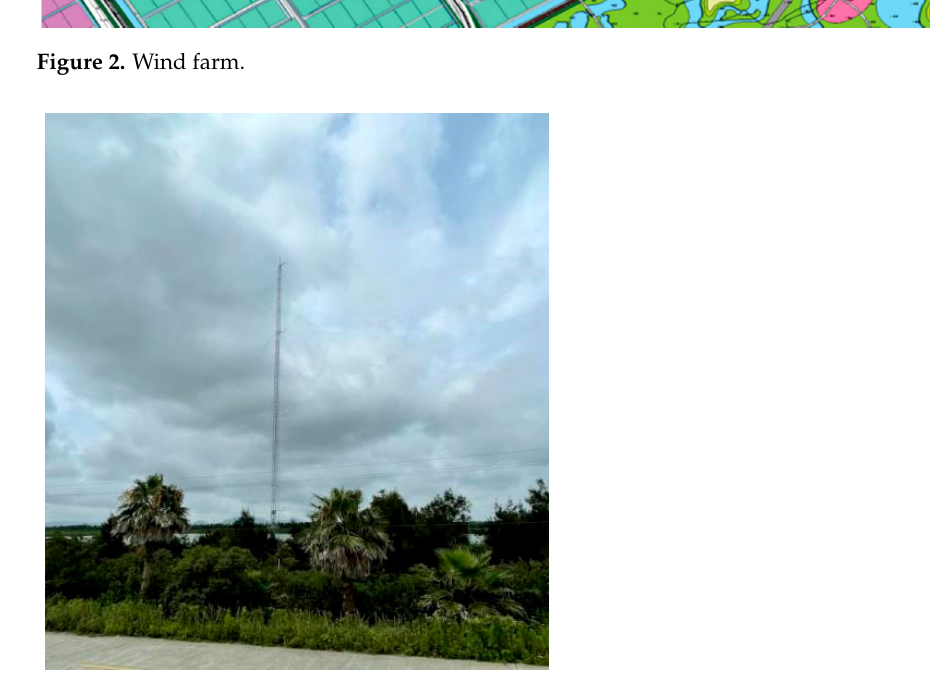
Figure 3. Wind measuring tower.